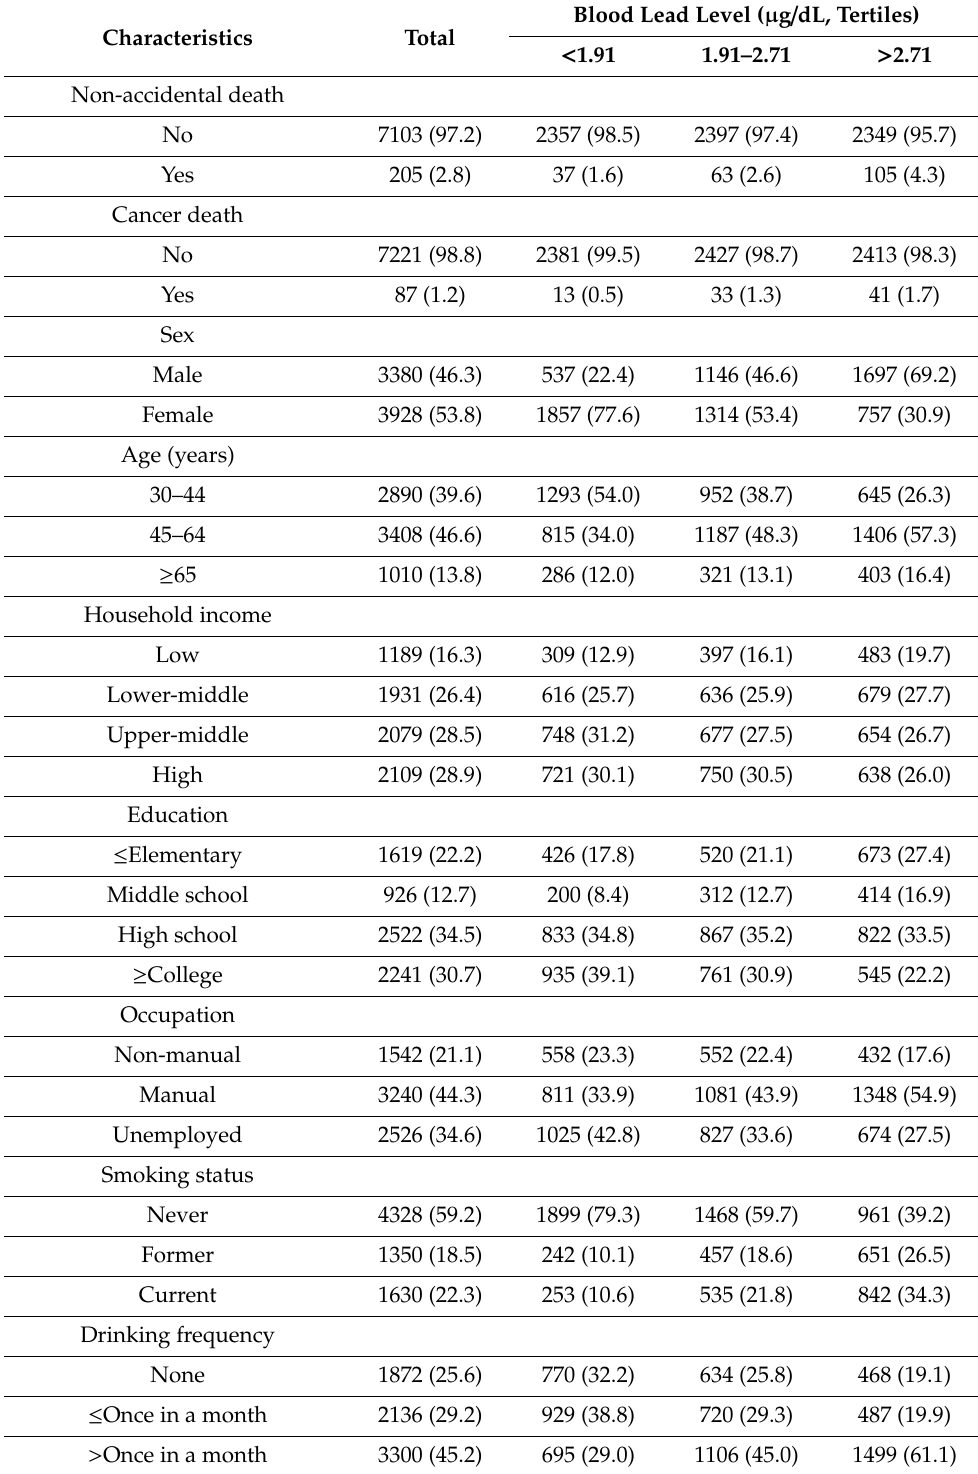
Table 1. Baseline characteristics of study subjects by blood lead level, n